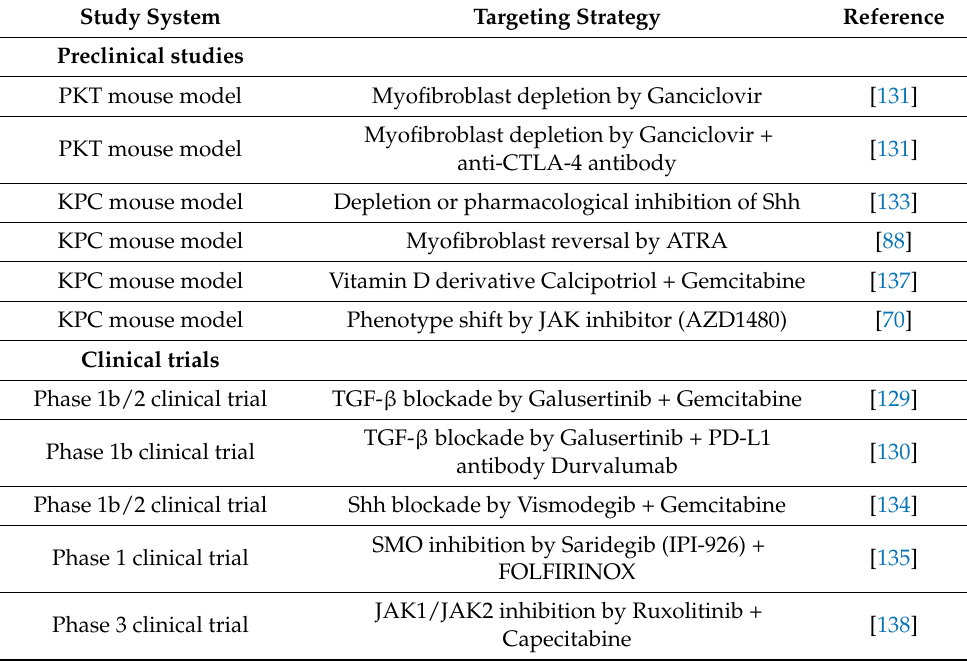
Table 1. Overview of the cited therapeutic approaches targeting carcinoma associated fibroblasts